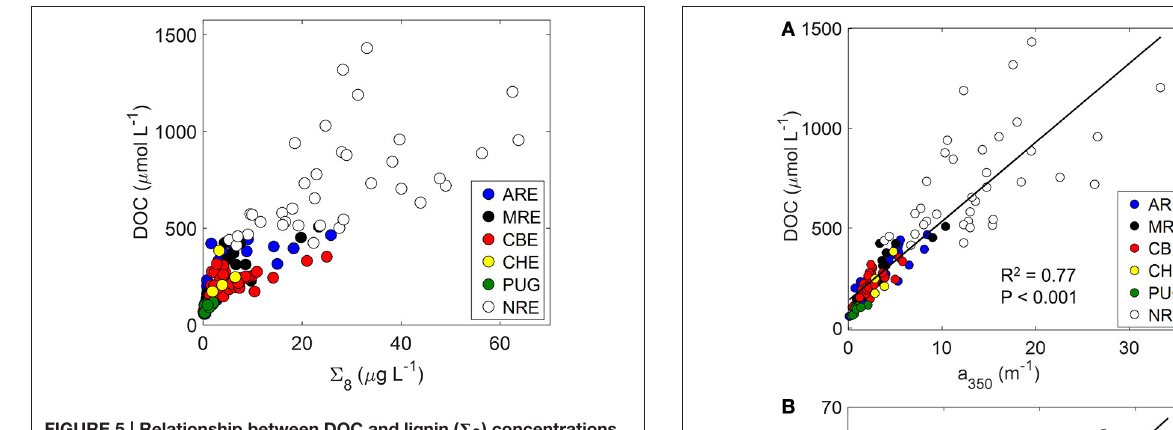
FIGURE 5 | Relationship between DOC and lignin ( 6 8 ) concentrations for the six estuaries in this study.